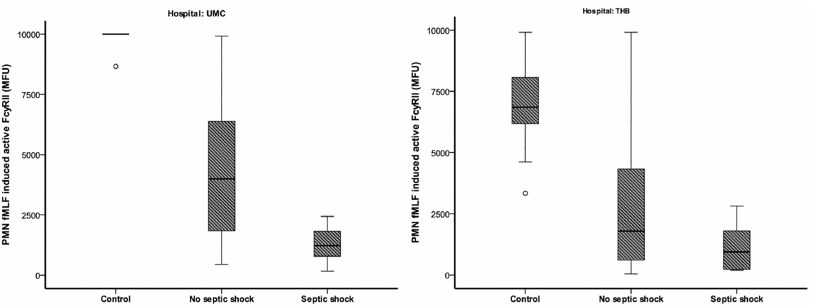
Fig 2. FMLF-induced Fc γ RII expression on PMNs. RelationbetweenfMLF-induced Fc γ RII expression on PMNs (mean fluorescence intensities; MFI in arbitrary units; AU) and the development of inflammatory complications. Complications are depictedaccording to the sepsisconsensusconferenceand dividedby hospital:University MedicalCenter Utrecht (UMC), Tyberberg HospitalStellenbosch(THB). In UMC ( A )a significantdecreasedresponsiveness was found in all patients (p < 0.001) comparedto controls. In addition,a statistically significantdifferencewas found between patientswith septic shock and patients without (p < 0.001). In TBH ( B )a significantdecreased responsiveness was found in all patients(p < 0.001)comparedto controls. A statistically significantdifferencewas found between patientswith and withoutseptic shock (p = 0.001).